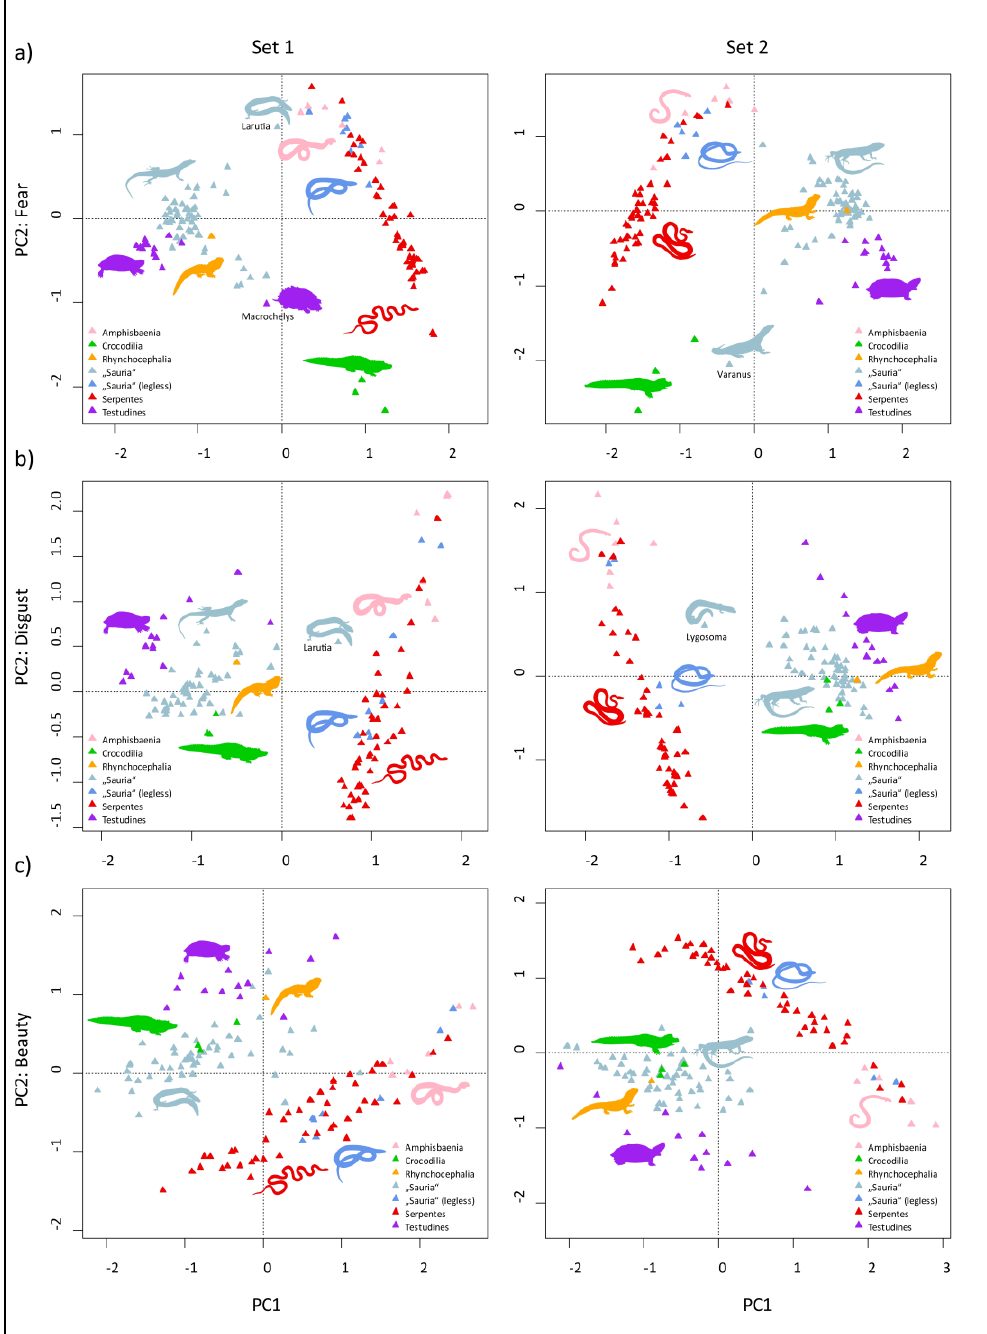
Figure 3. Plotting of the species scores onto PC1 and PC2 axes of the PC analyses, separately for ( a ) fear, ( b ) disgust, and ( c ) beauty rankings. In all cases, PC1 axis closely correlates with the respective mean values (e.g., PC1 fear correlates with mean fear), and the correlations are positive in Set 1 a, b, and negative in Set 1 c and Set 2 a, b, c. Please note that the positivity and negativity of the values of the PC axes are arbitrary and thus not fully comparable across the individual projections. For direct comparisons, please heed the colors that mark the specific taxa / groups and the distance of single points (triangles) and the groups they form from the other